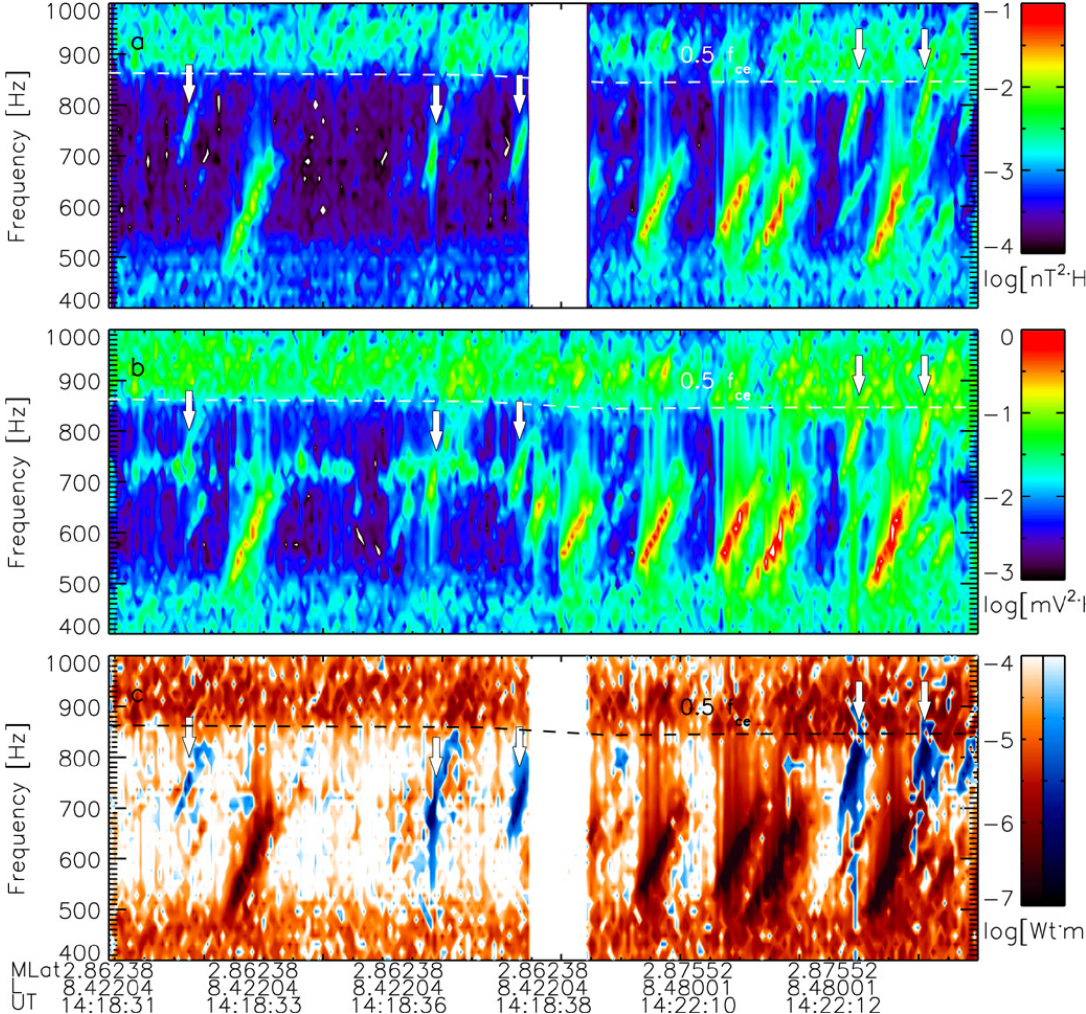
Fig. 2. Detailed time-frequency power spectrograms of magnetic (top) and electric (middle) field fluctuations near the source region recorded by the SCM (a) and EFI (b) instruments aboard THA on 26 July 2008. Frequency-time dependence of the Poynting vector direction of forward and reflected chorus observed by the SCM/SCW (c) . The field aligned waves elements are marked with red color and the elements propagated in opposite direction are marked with blue color. Spectral power is in logarithmic scale. The reflected chorus elements are marked with white